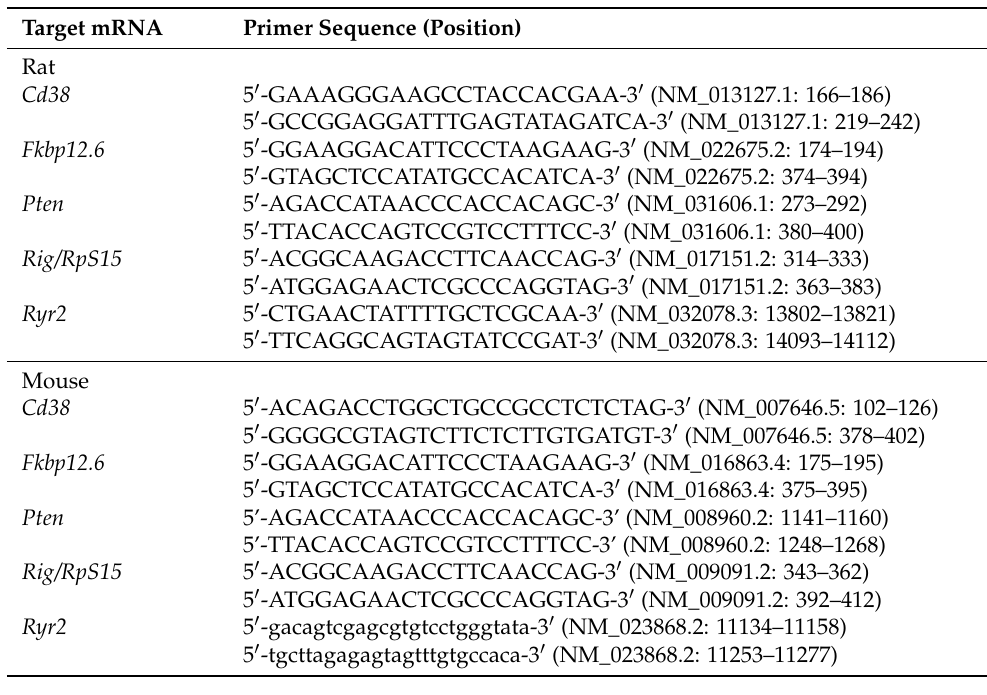
Table 1. PCR primers for real-time